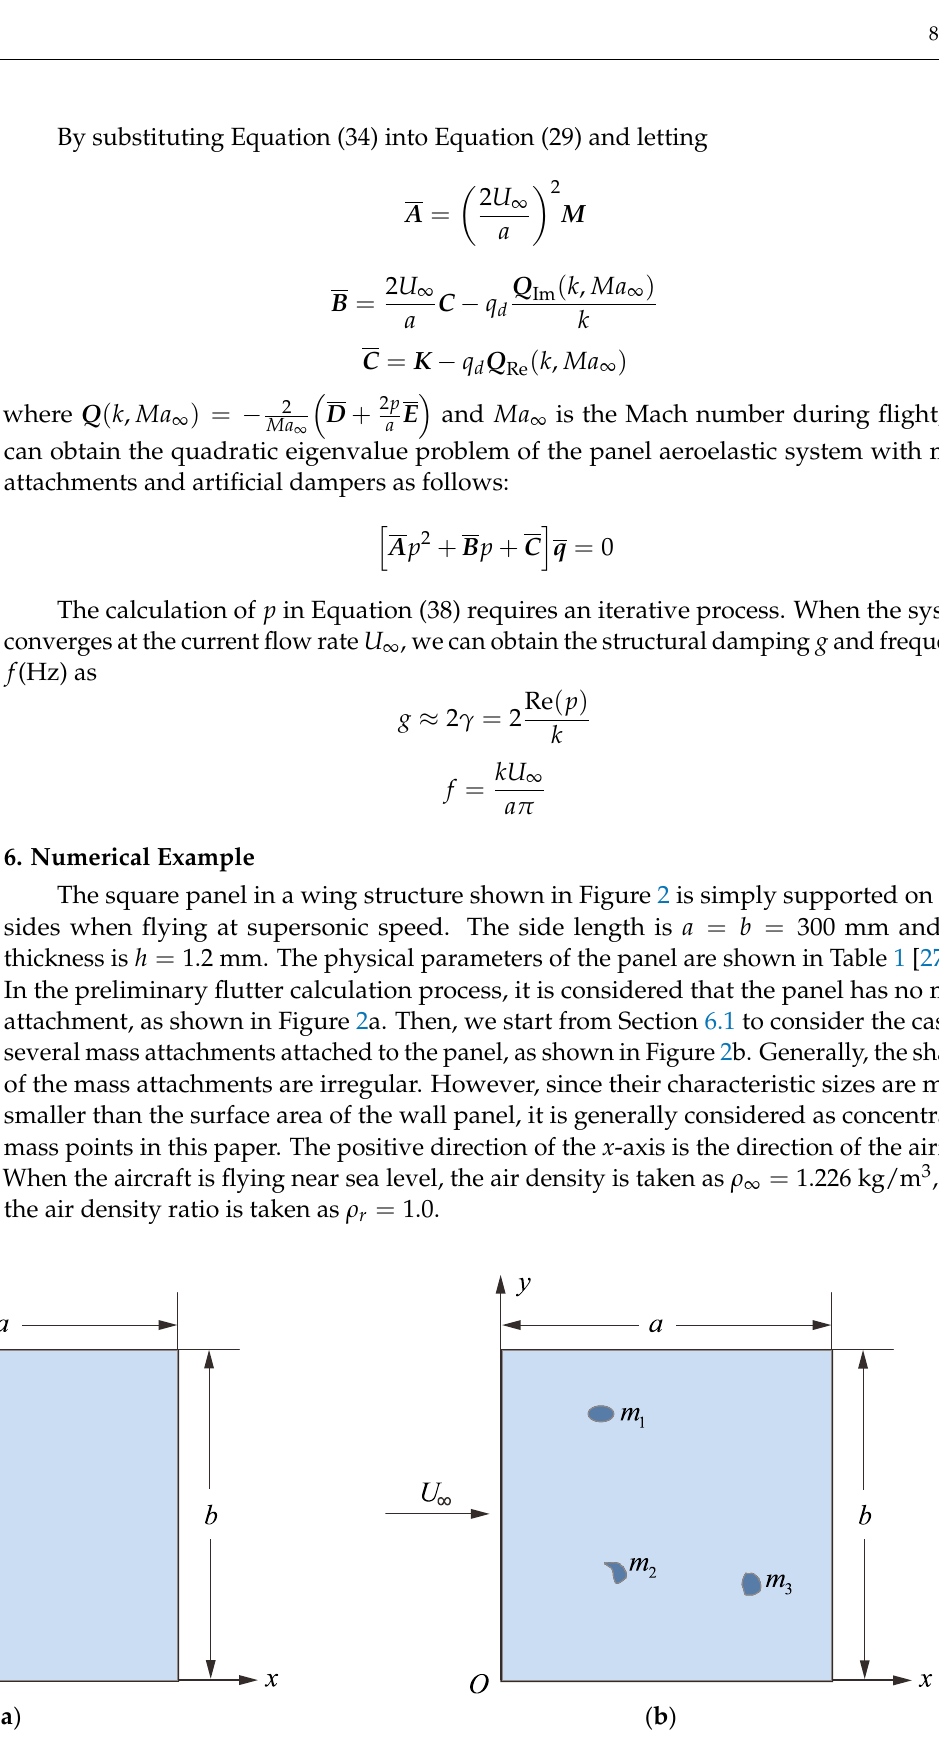
Figure 2. A square panel with simply supported boundaries on four sides: ( a ) with no mass at- tachment; ( b ) with several mass attachments. Table 1. Physical parameters of the square panel.